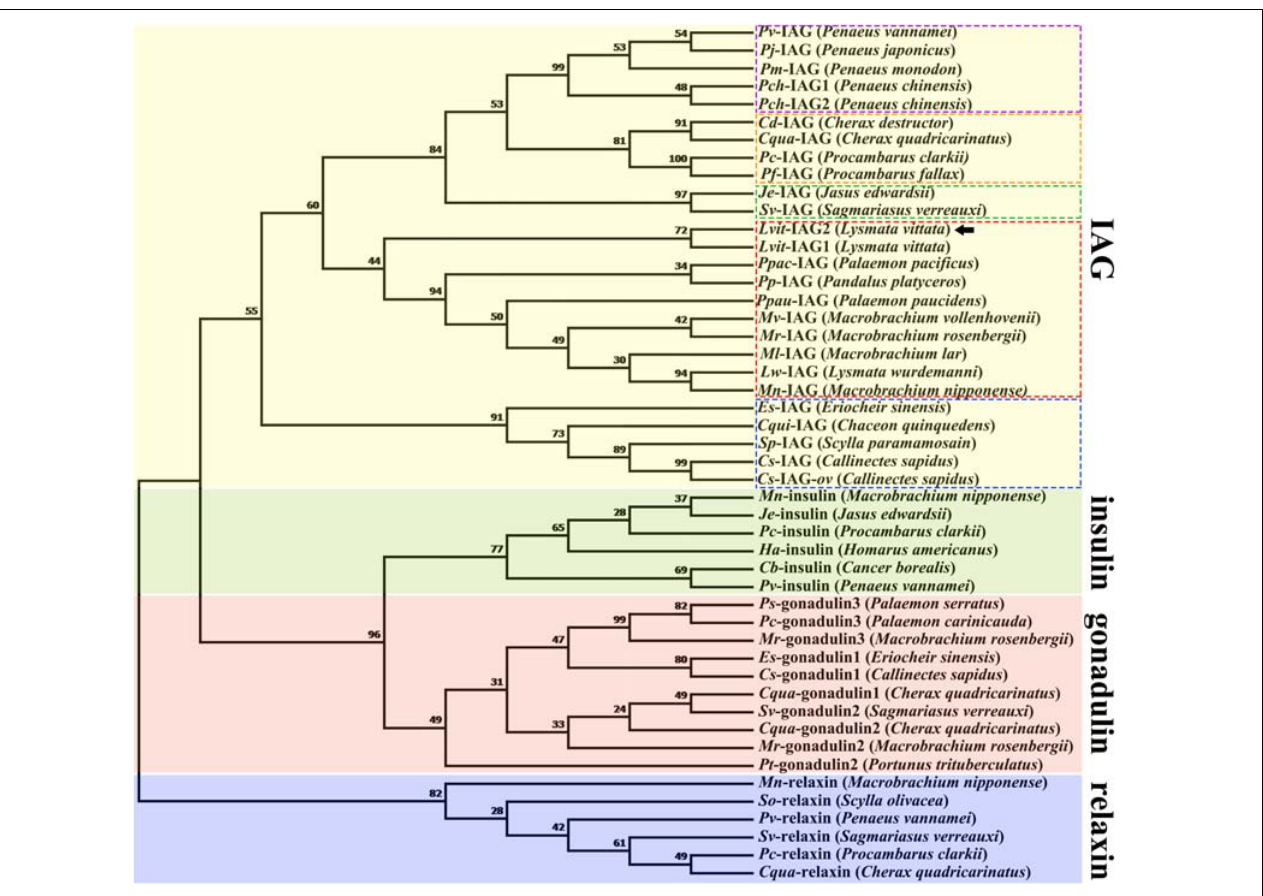
FIGURE 2 | Phylogenetic tree of amino acid sequences of the insulin and related peptide in decapods. Except for Lvit -IAG2 (GenBank accession number: MT114197, Lysmata vittata ) and Cs- IAG -ov (GenBank accession number: APC42865.1, Callinectes sapidus ), IAG sequences shown in Table 2 ; other sequences were obtained from Veenstra (2020). Deduced amino acid sequences of insulin and related peptide excluding signal peptide were used for phylogenic analysis. Phylogenetic analysis was conducted by Maximum Likelihood method based on the JTT matrix-based model in MEGA7. The percentage of replicate trees in which the associated taxa clustered together in the bootstrap test (1,000 replicates) was shown next to the branches. Four major clades were represented by different colors. Each subclade of IAGs was noted by a different color of dashed box. Lvit- IAG2 was marked by a solid